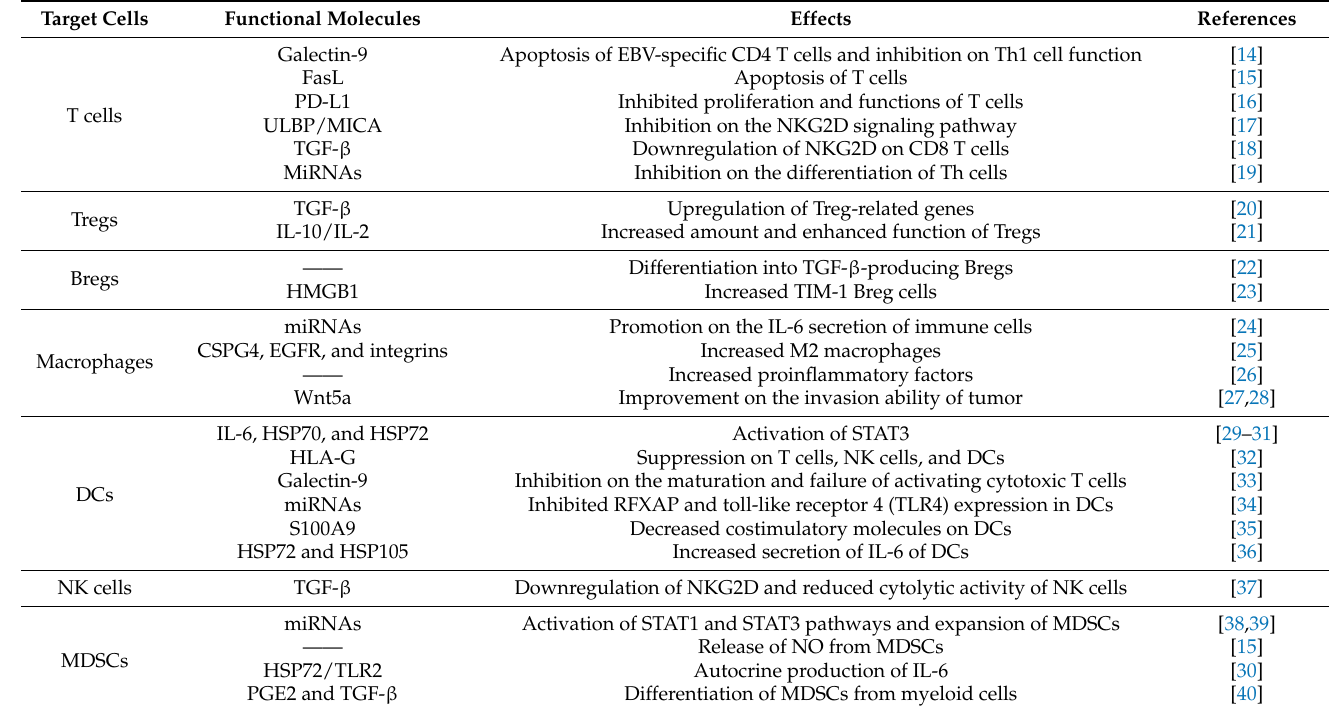
Figure 2. Tumor-derived exosomes contribute to the formation of the immunosuppressive tumor microenvironment. Tumor-derived exosomes can either suppress immune cells or contribute to the activation of immune cells. Suppression: induce T cells’ apoptosis and suppress their activation and proliferation, inhibit the differentiation and maturation of DCs, and suppress the immunity ability of NK cells. Activation: promote the proliferation and function of regulatory T and B cells (Tregs and Bregs), the polarization of M2 macrophages, and the function and expansion of MDSCs. Table 1. Immunosuppressive role of tumor cell-derived